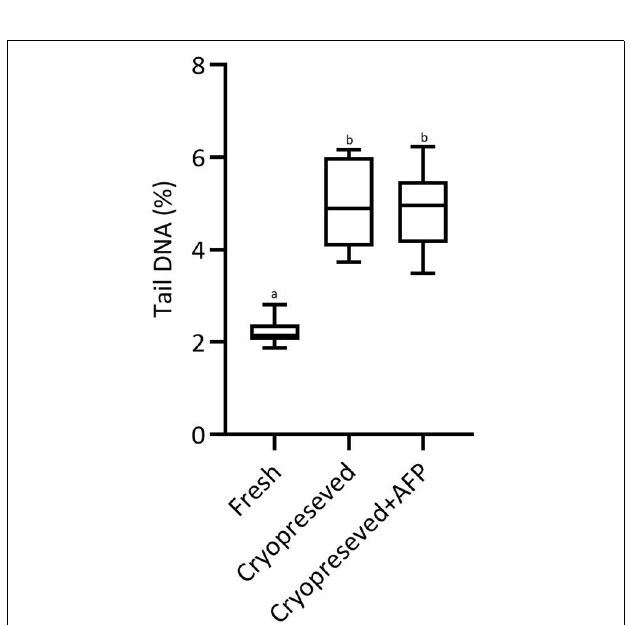
FIGURE 5 | The percent of DNA in the tail as measured in the comet assay before (fresh) and after cryopreservation of sterlet spermatozoa without (cryopreserved) and with supplementation of 10 µ g/mL AFPI (cryopreserved + AFP). Values with different lower-case letters are significantly different ( p < 0.05, non-parametric Kruskal–Wallis ANOVA followed by multiple comparison of mean ranks for all